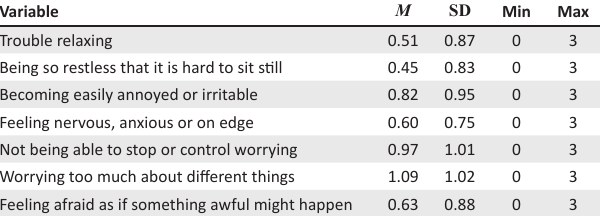
TABLE 4: Descriptive characteristics for observed variables.